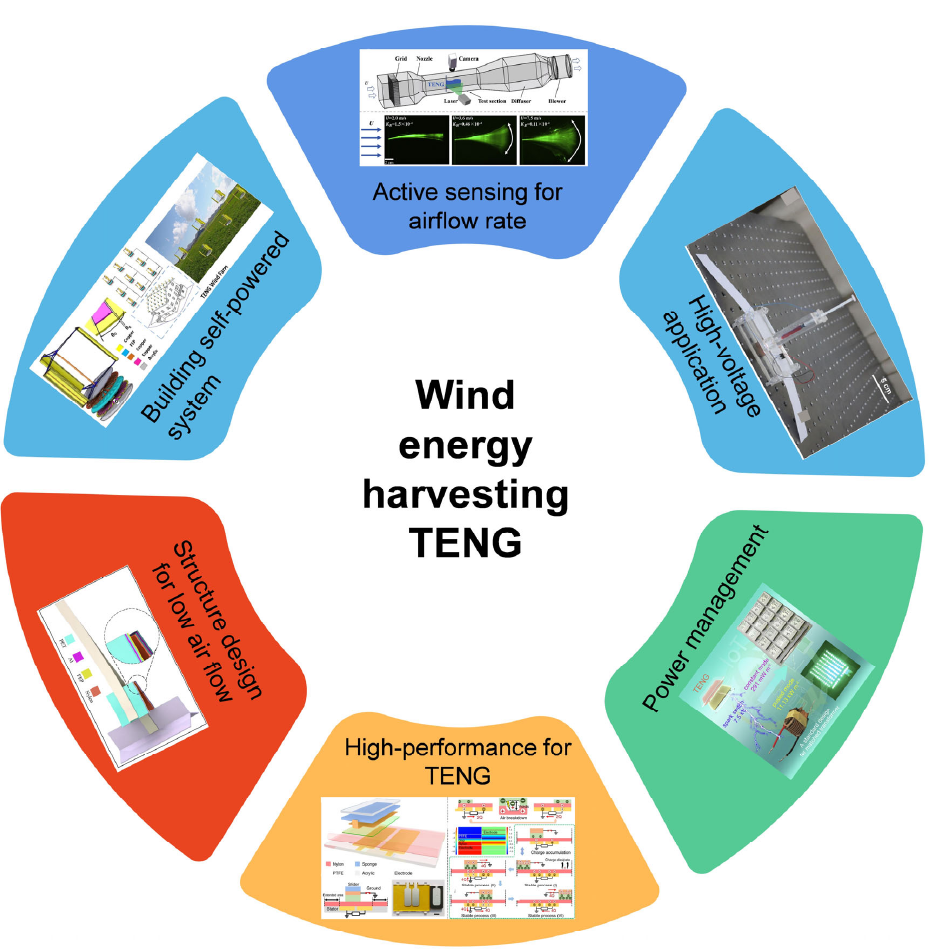
Figure 9. Schematic diagram of various WD-TENG’s application fields (reproduced with permission [74]. Copyright 2020, Nano Energy ); (reproduced with permission [75]. Copyright 2017, Nano Energy ); (reproduced with permission [76]. Copyright 2020, Nature Communications ); (reproduced with permission [77]. Copyright 2021, Joule ); (reproduced with permission [78]. Copyright 2021, Nano Energy ); (reproduced with permission [79]. Copyright 2017, Nano Energy ).